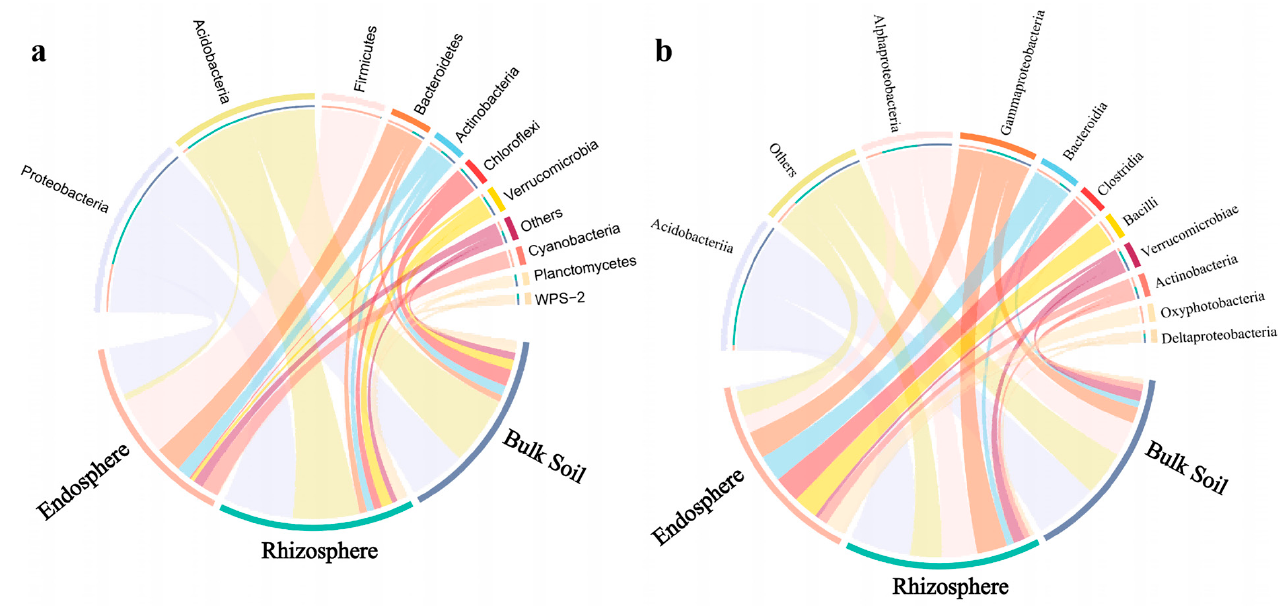
Table 1. Mean relative abundances of top 10 differential phyla (%) in different sample types.